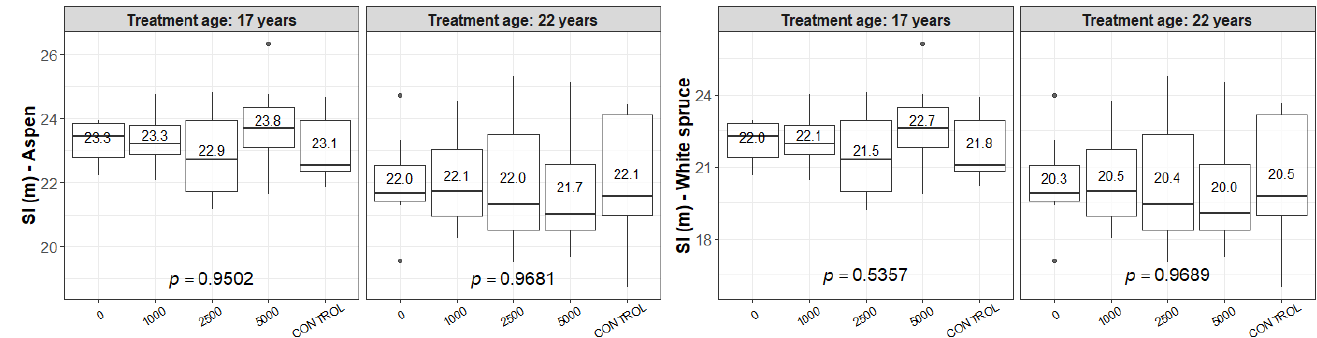
Figure 4. Summary of site index by treatment by species. Site index (SI) represents tree height at a reference age of 50 years total age. Numbers show mean values. p -values are from mixed-model ANOVA.